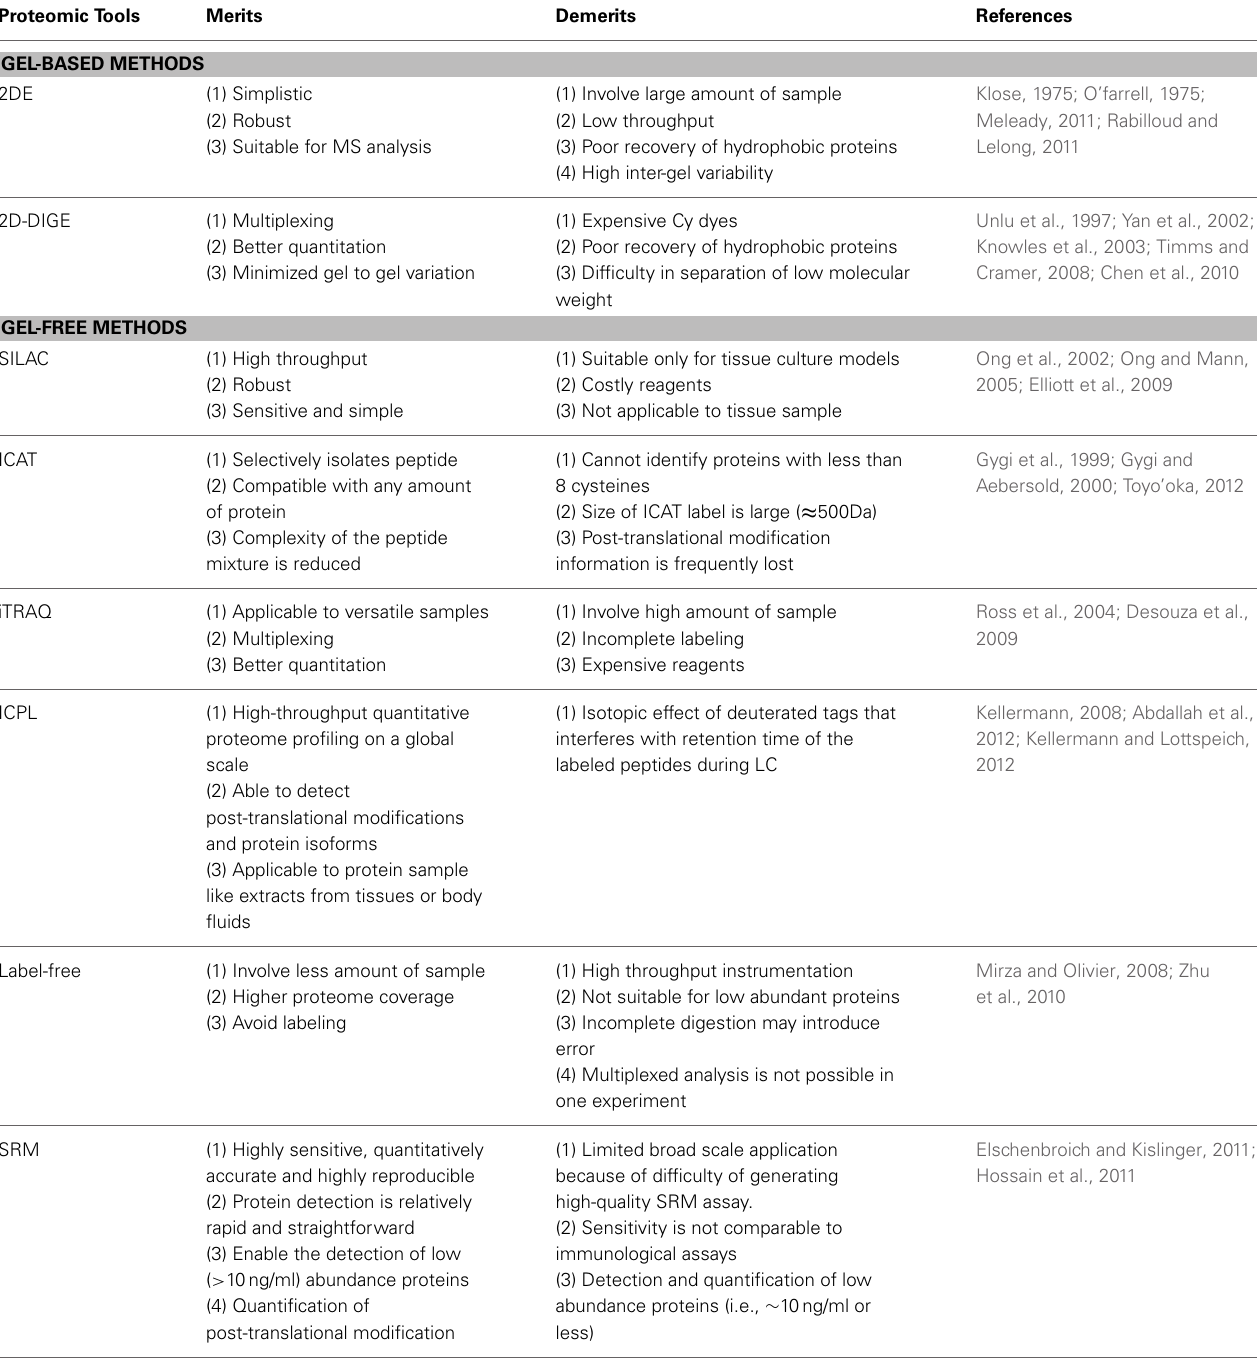
Table 2 | Different quantitative proteomic approaches with its merits and demerits. Proteomic